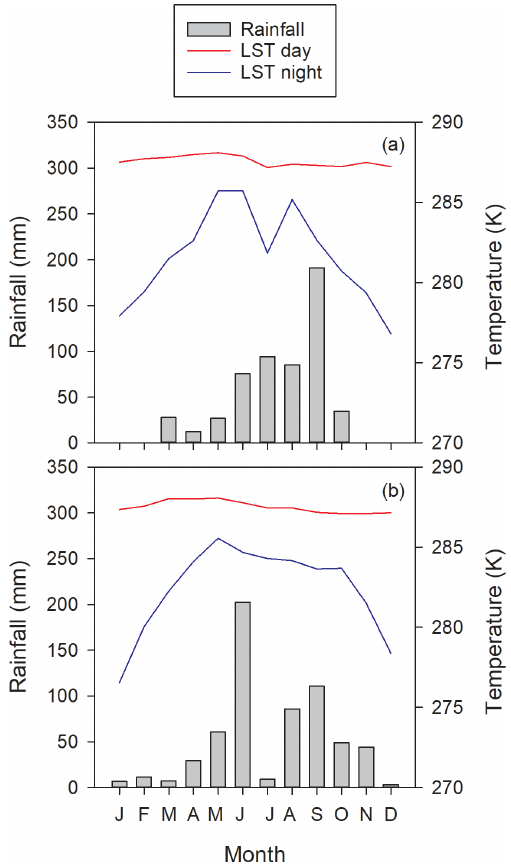
Figure 7. Monthly rainfall and land surface temperature (LST) dur- ing years (a) 2017 and (b) 2018 at the Bernal site. The LST values correspond to the 13:30 (LST day) and 01:30 (LST night) MODIS Aqua satellite